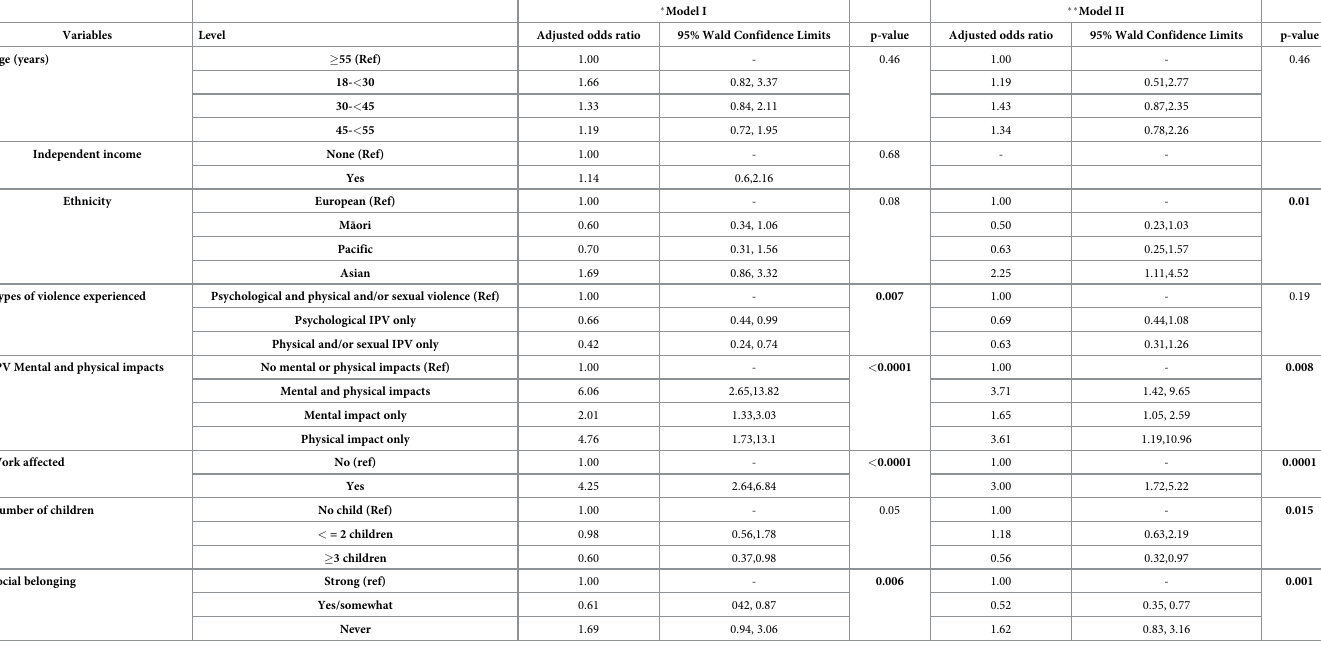
Table 4. Determinants of help-seeking by men who experienced IPV, compared to men who did not seek